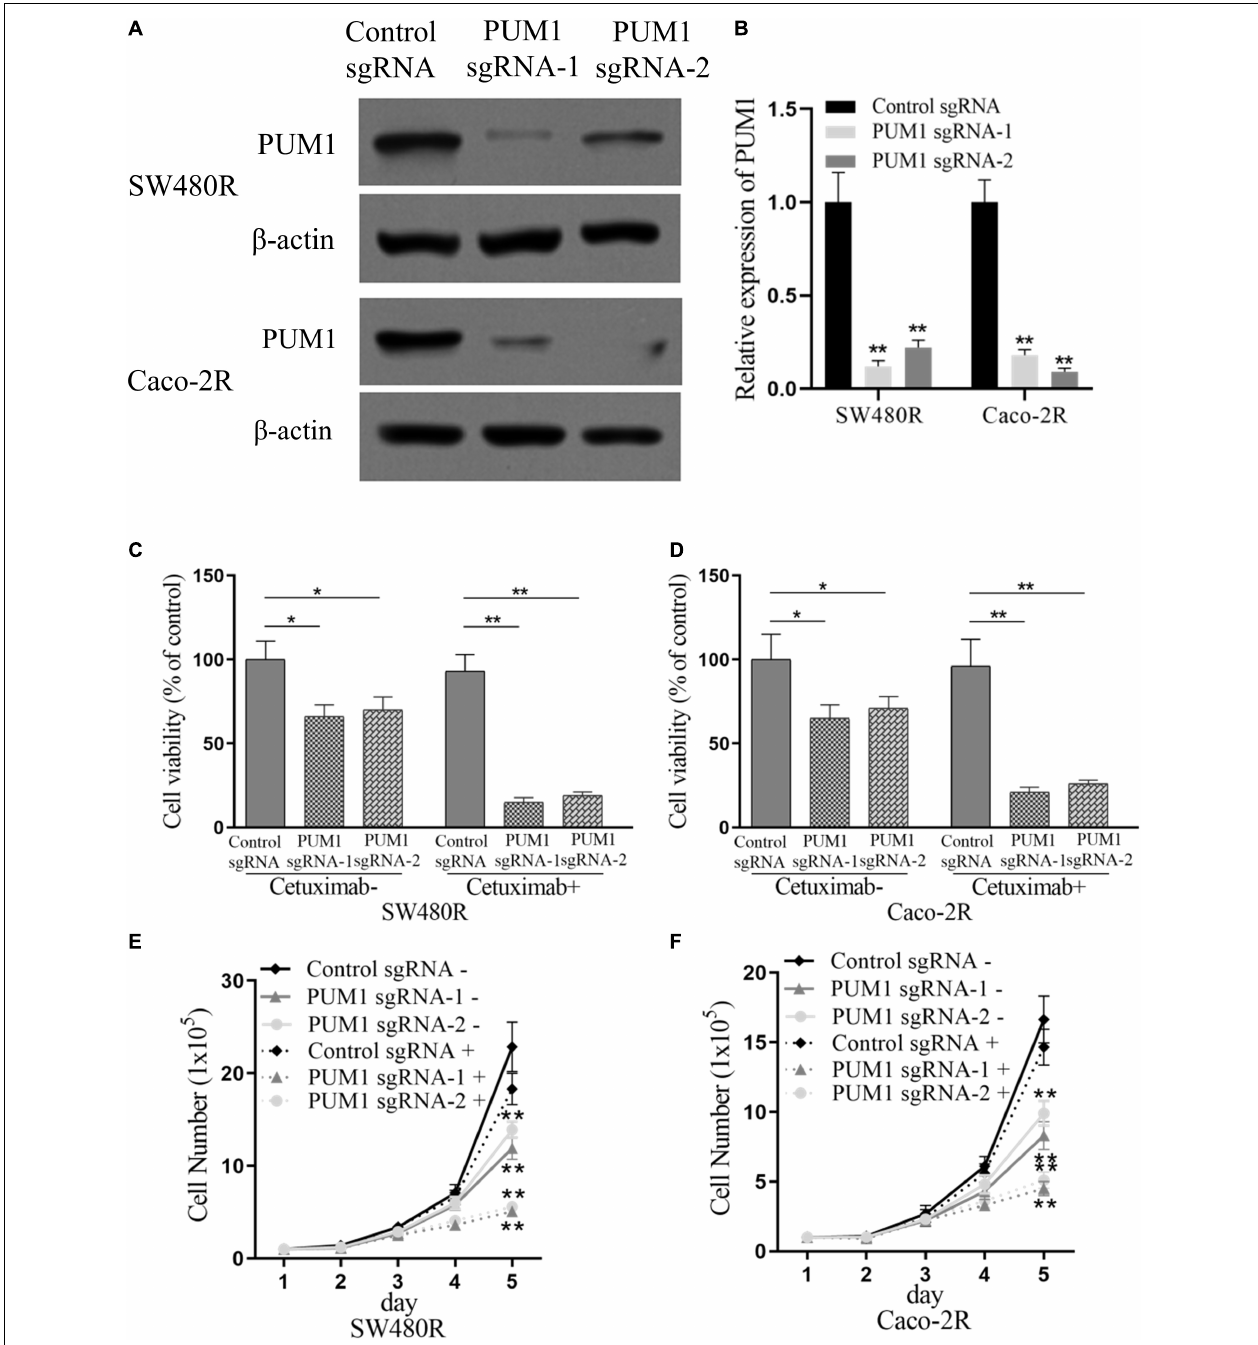
FIGURE 2 | Suppression of pumilio RNA-binding family member 1 (PUM1) inhibits proliferation of cetuximab-resistant colon cancer cells. (A,B) Western blotting assay for the levels of PUM1 in SW480R and Caco-2 colon cancer cells. β -actin served as a loading control. (C) SW480R and (D) Caco-2R cells were incubated with or without cetuximab for 72 h, and cell proliferation was determined using the Cell Counting Kit-8 (CCK-8) assay. (E) SW480R and (F) Caco-2R cells were grown in six-well plates, and the cell number was determined. Cetuximab+ and cetuximab– represent the culture media with and without 10 µ g/ml cetuximab, respectively. Data were presented as mean ± SD of three independent experiments. * p < 0.05; ** p <